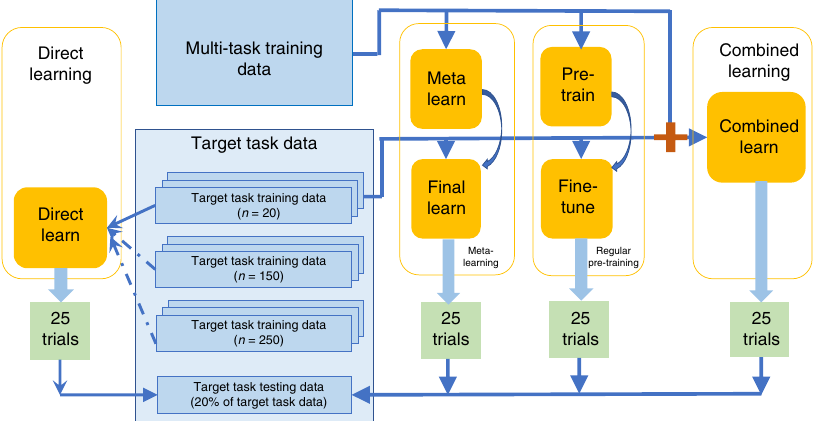
Fig. 2 Data fl ow schematic. 25 trials are conducted each for the meta-learning, regular pre-training, combined learning, and direct